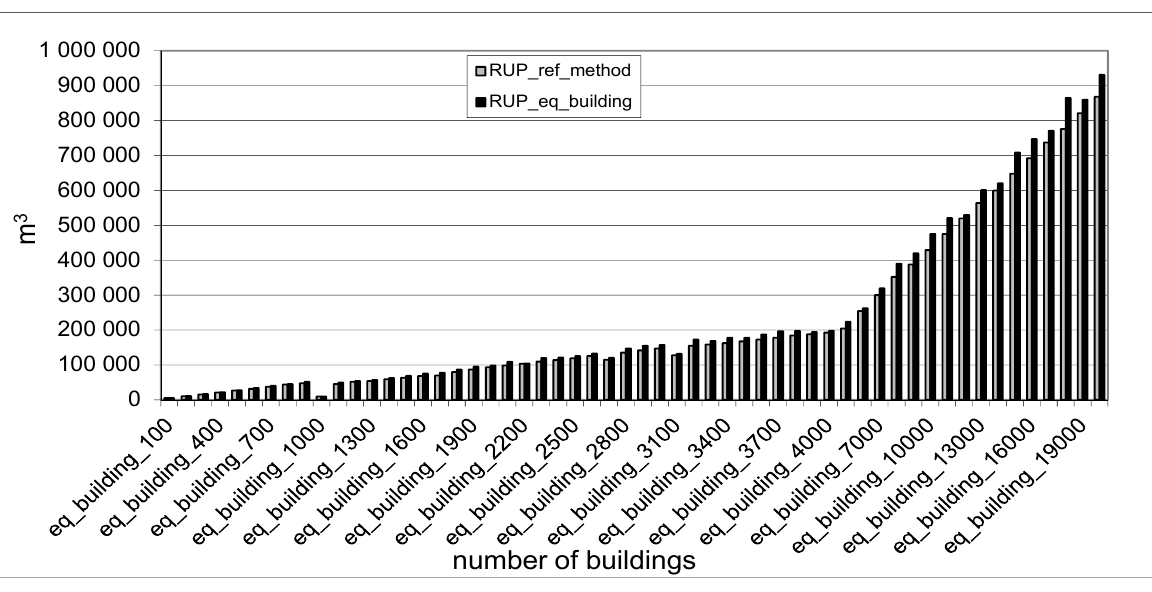
Figure 3. Comparison of the RUP for the situation type “individual housing with garden” calculated by “reference method” (RUP_ref_method) and “equivalent building”